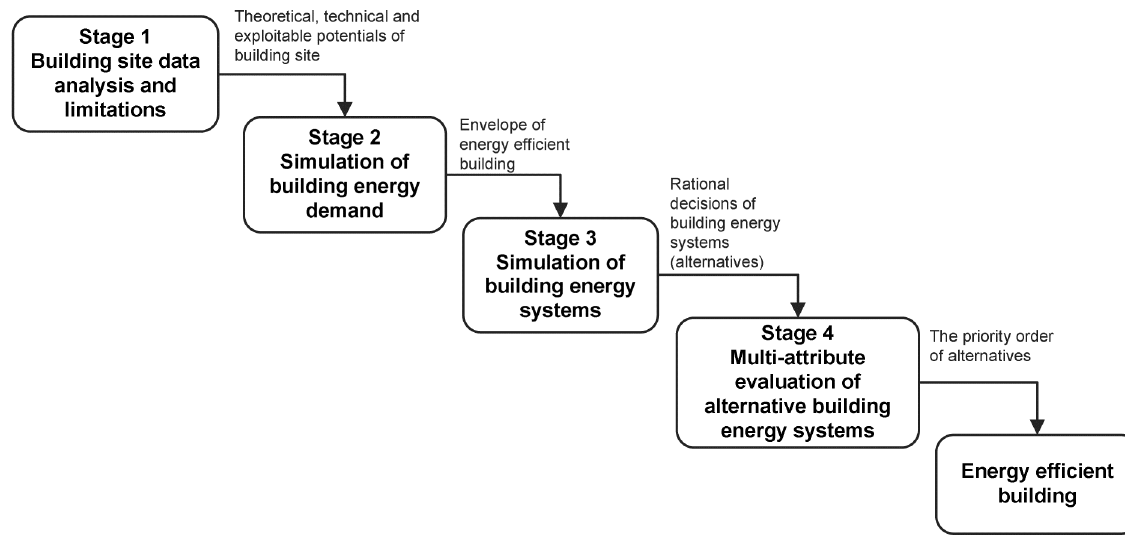
Fig. 1. Conceptual framework of main energy efficient building planning and design stages